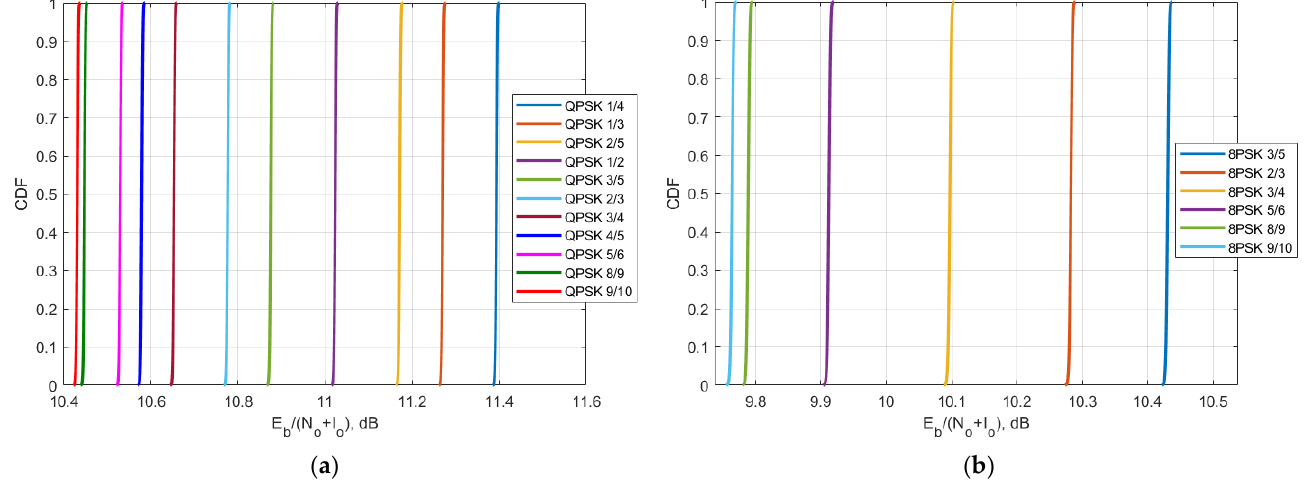
Figure 17. The CDF of E b /N o +I o of Yamal 90E: ( a ) for QPSK modulation; ( b ) 8PSK modulation.